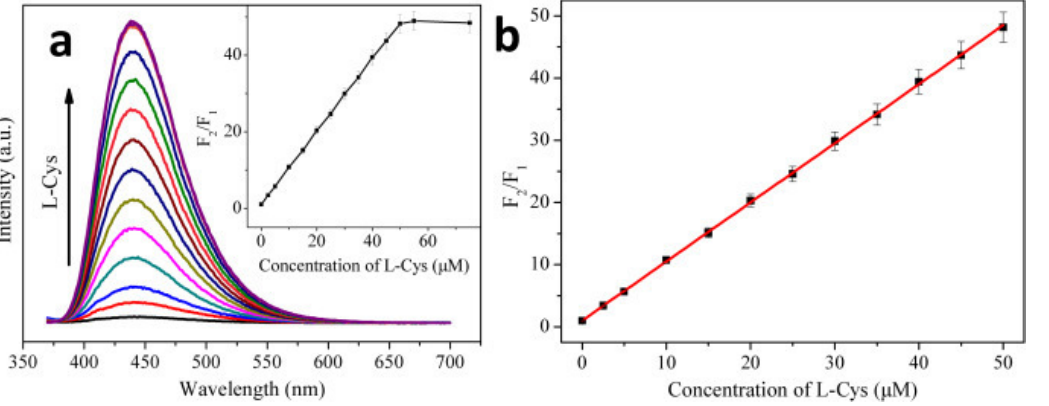
Figure 5. ( a ) PL spectra of the NCD – Hg 2+ system in the presence of L-Cys with increasing concen- trations (from bottom to top: 0, 2.5, 5, 10, 15, 20, 25, 30, 35, 40, 45, 50, 55, and 75 μM). ( b ) A linear relationship of F 2 /F 1 versus the concentration of L- Cys over the range from 0 to 50 μM. The error bar represents the standard deviation of three measurements (pH 7.0, 0.025 M PBS) , λ ex = 360 nm, [NCDs] =16 μg mL −1 (μg = microgram, mL = milli liter), [Hg 2+ ] = 50 μM; F 1 and F 2 are the PL intensities of the NCD – Hg 2+ system at 440 nm in the absence and presence of L-Cys, respectively) (( a , b ) is re- produced with the permission from Ref. [100]).